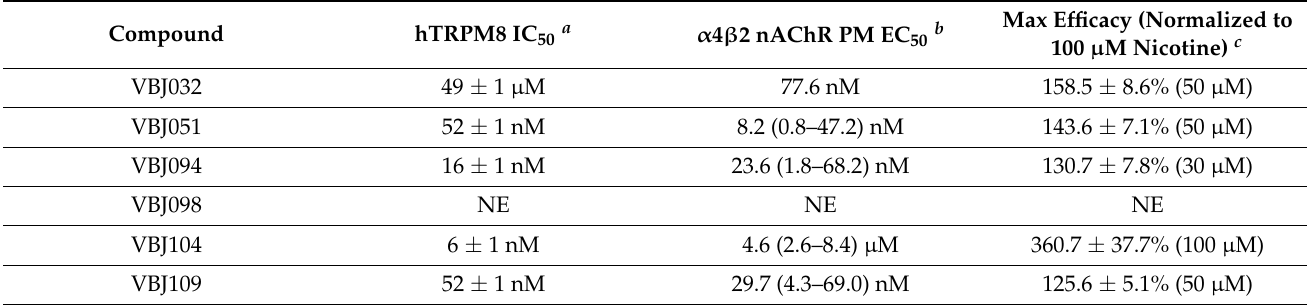
Table 1. In vitro Ca2 + flux